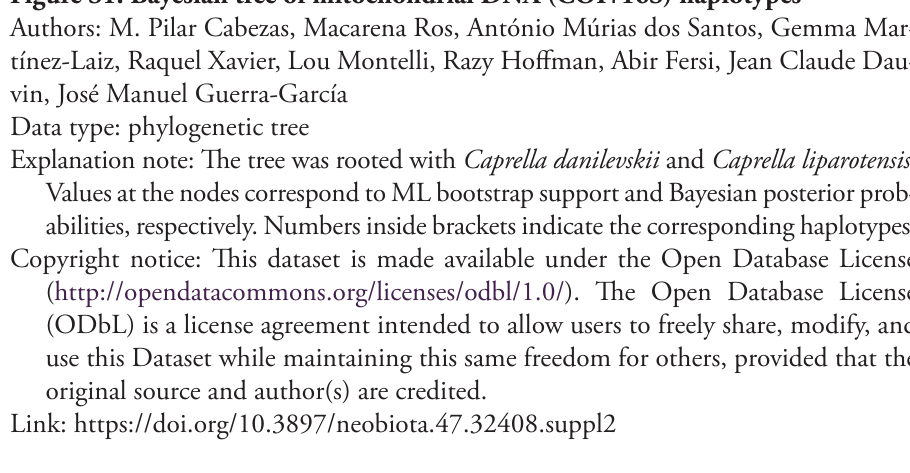
Figure S1. Bayesian tree of mitochondrial DNA (COI+16S)